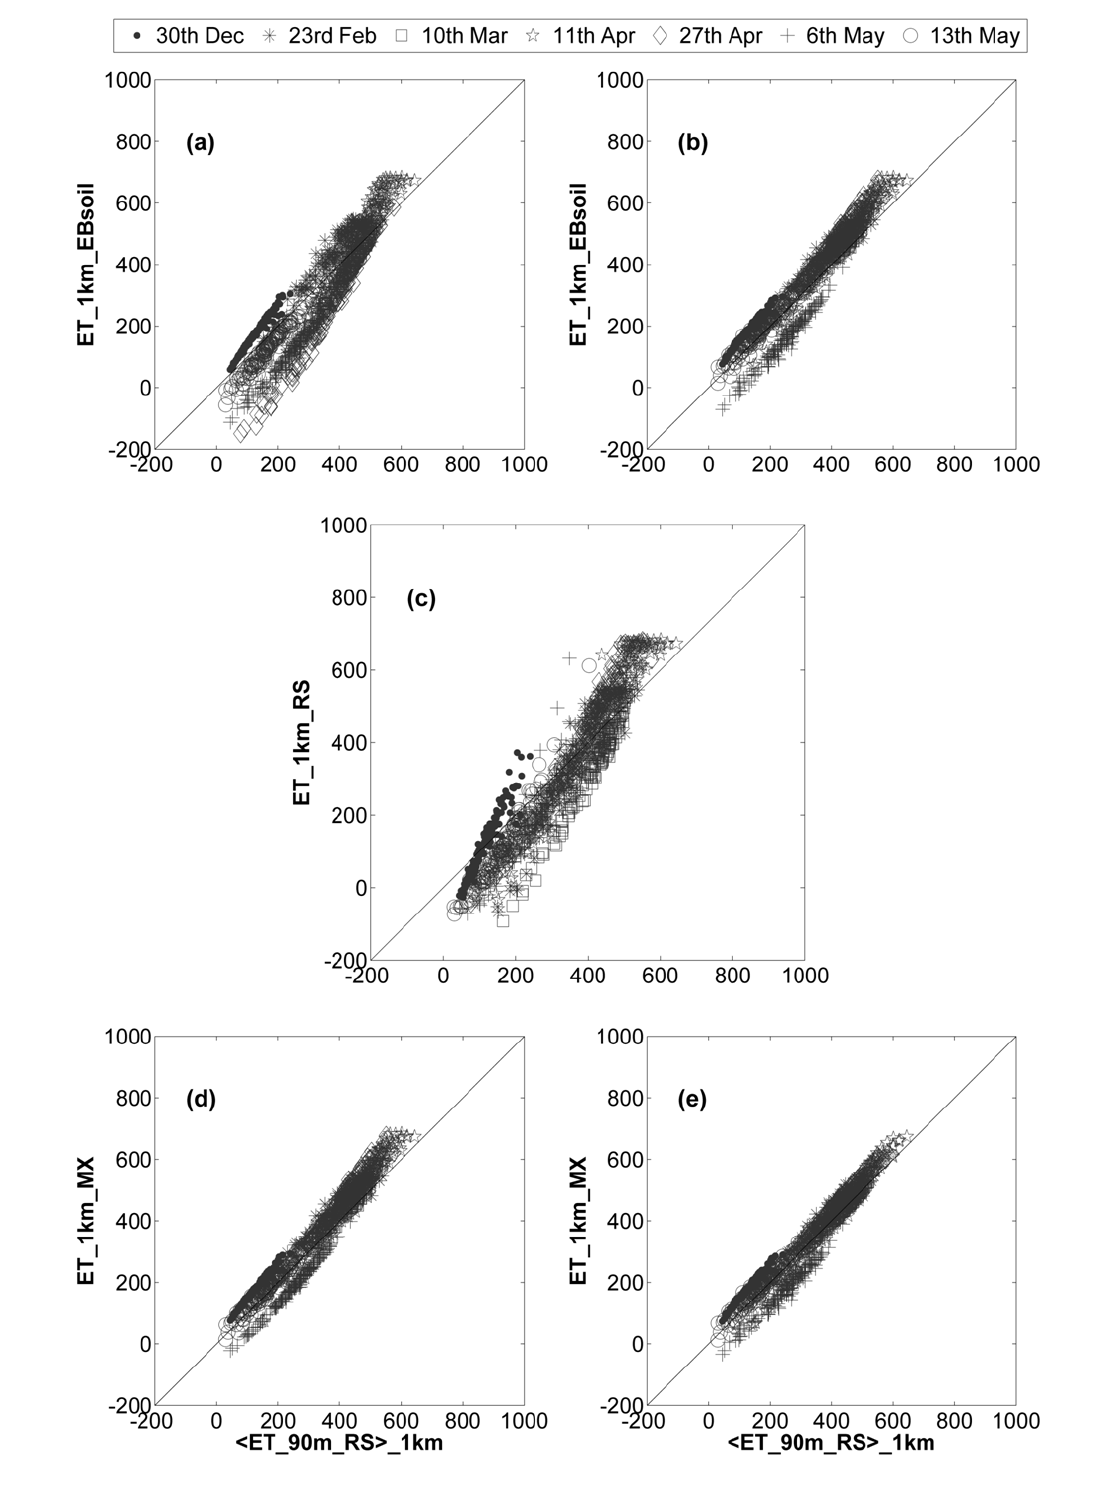
Figure 12. The ET simulated at 1-km resolution is plotted against the 90-m resolution simulated ET, aggregated at 1-km resolution, for data over the Yaqui region, on the seven ASTER overpass dates separately. The Tends used as input to the EF_SEB-1S model consist of ( a ) the Tends simulated by EBsoil with the RI and ( b ) MO aerodynamic resistance, ( c ) the Tends retrieved from 1-km resolution data, ( d ) the Tends simulated with the mixed modeling approach using α ends_1km and ( e ) the Tends simulated with the mixed modeling approach using α